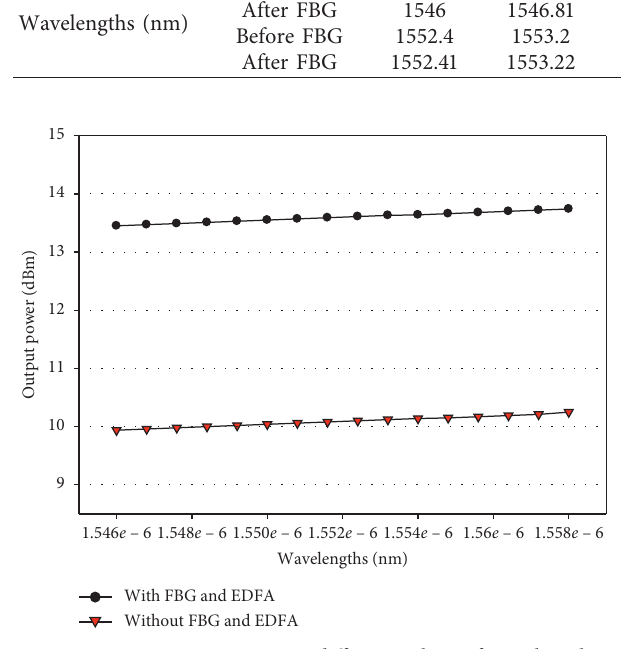
Figure 14: Output variation at different values of wavelengths.